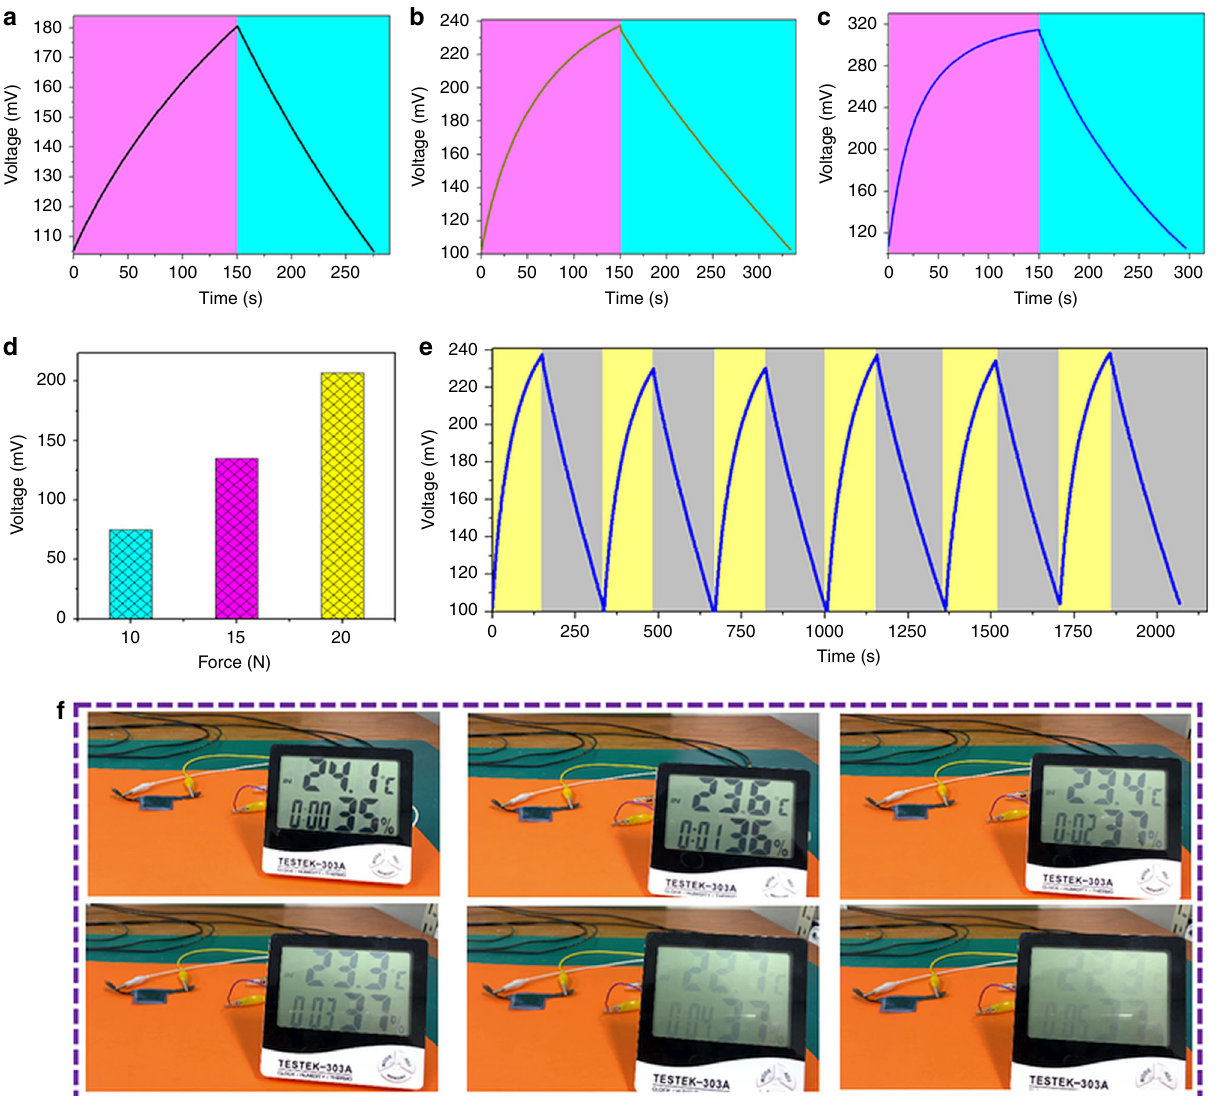
Fig. 6 Mechanically driven self-charging properties of the siloxene SCSPC. a – c Self-charging properties of the siloxene SCSPC subjected to various levels of mechanical force of 10, 15, and 20 N. d Effect of applied compressive forces on the self-charging performance of the siloxene SCSPC. e Stability of the self-charging properties of the siloxene SCSPC subjected to a continuous compressive force of 15 N. f Practical application of the siloxene SCSPC capable of powering a multifunctional electronic display.